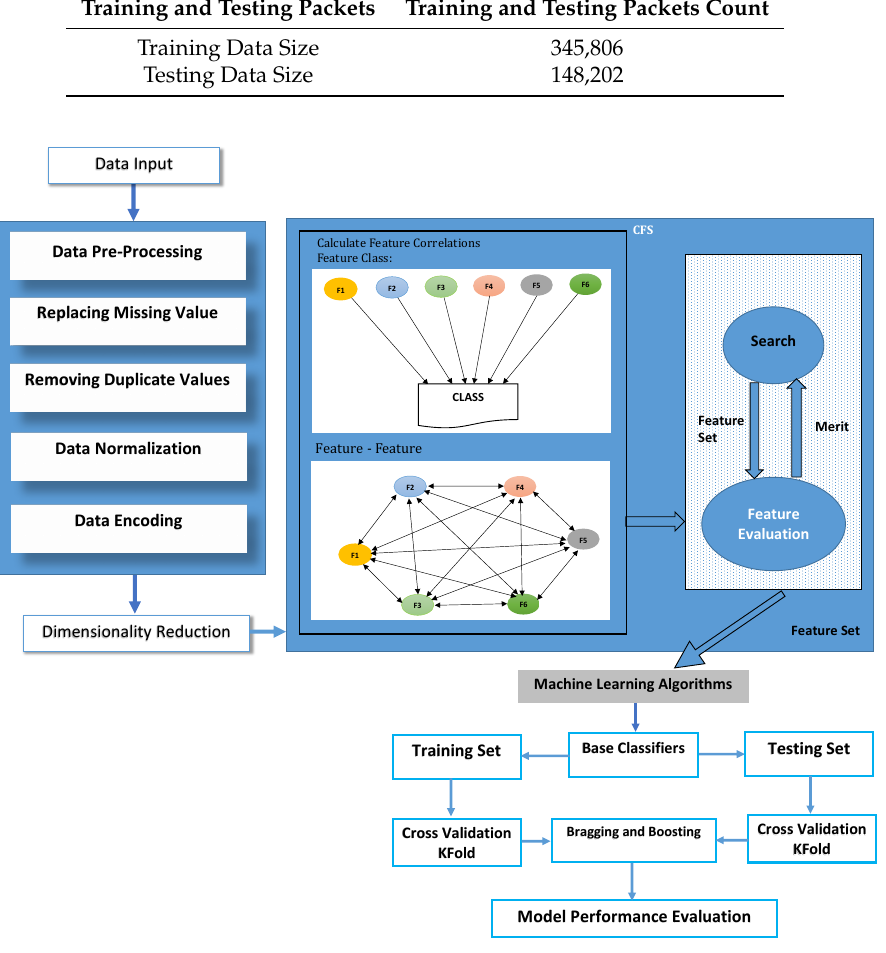
Figure 1. Proposed